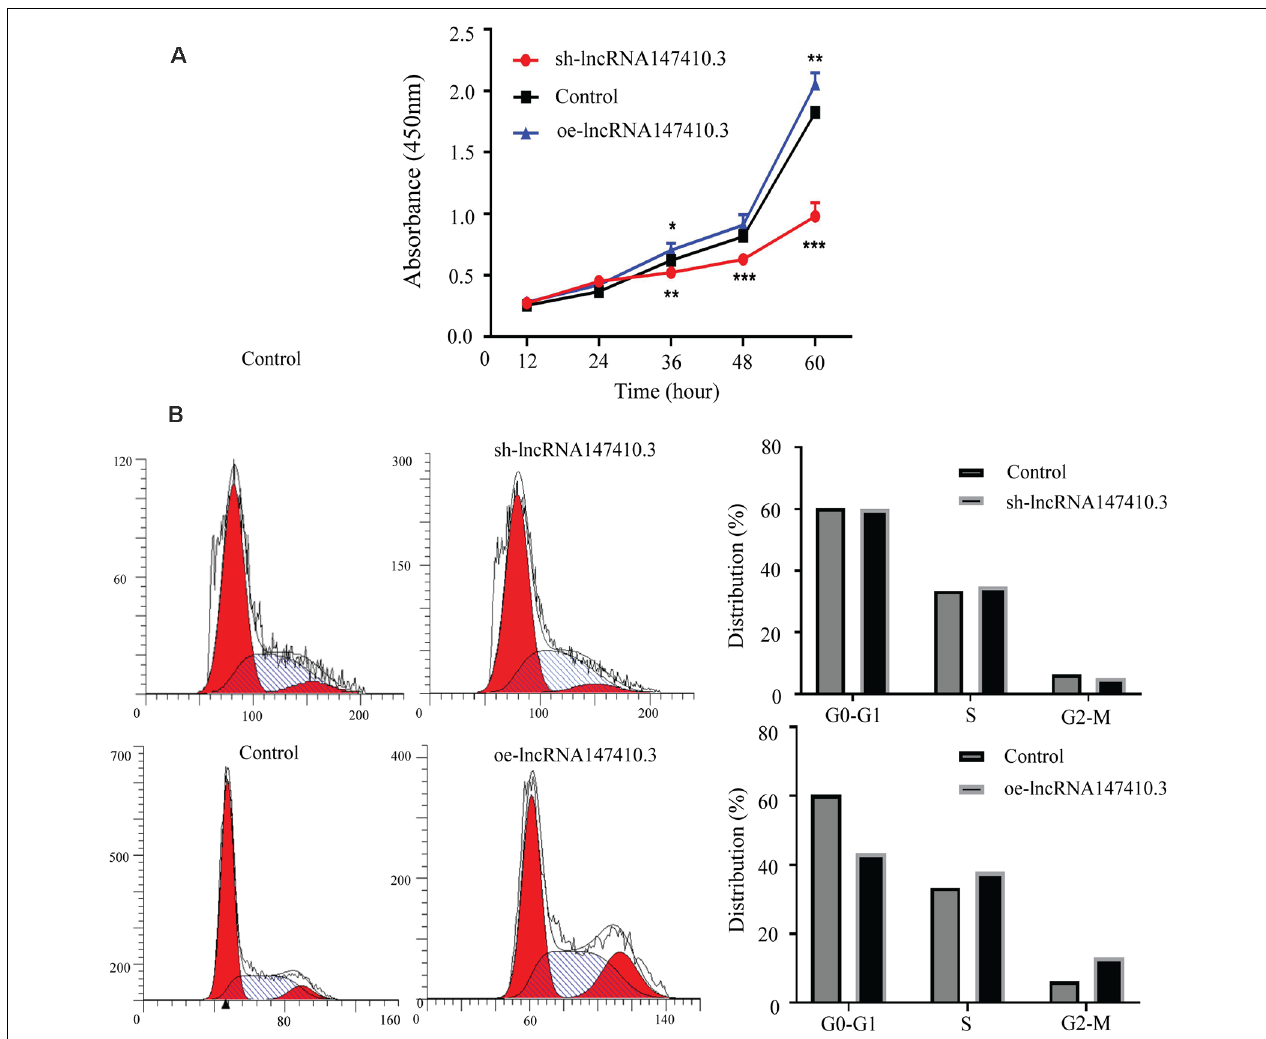
FIGURE 5 | Effects of lncRNA147410.3 on proliferation and cycle of BV-2 cells. (A) Cell proliferation was determined by CCK-8 assay which was performed in BV-2 cells transfected with sh-lncRNA147410.3 or oe-lncRNA147410.3 at 12, 24, 36, 48, and 60 h, later. All values are presented as mean ± SD for three independent experiments. * p < 0.05, ** p < 0.01, *** p < 0.001, Student’s t - test . (B) The cell cycle of BV-2 cells transfected with sh-lncRNA147410.3 or oe-lncRNA147410.3 was analyzed by Flow